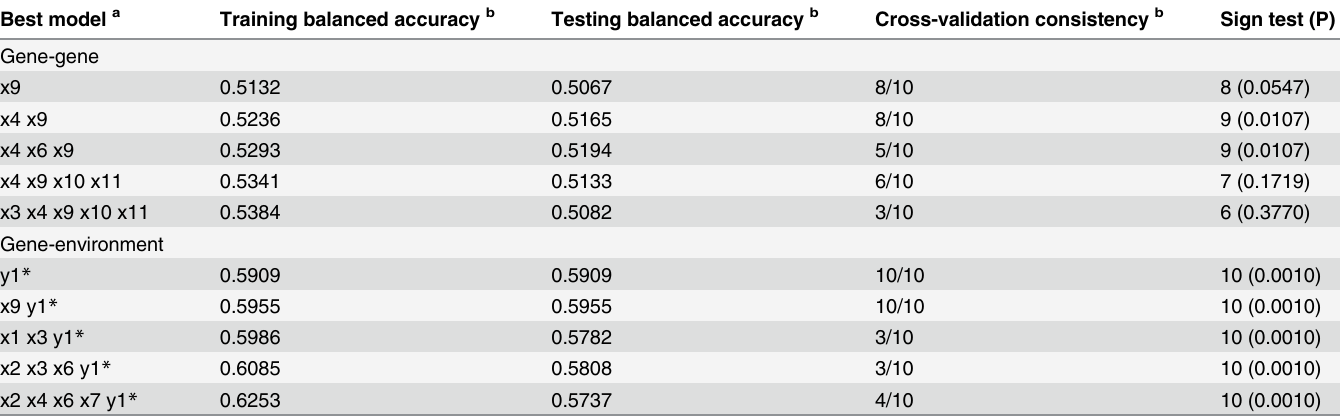
Table 3. Comparison of the best models identified by GMDR for gene-gene and gene-environment interactions.